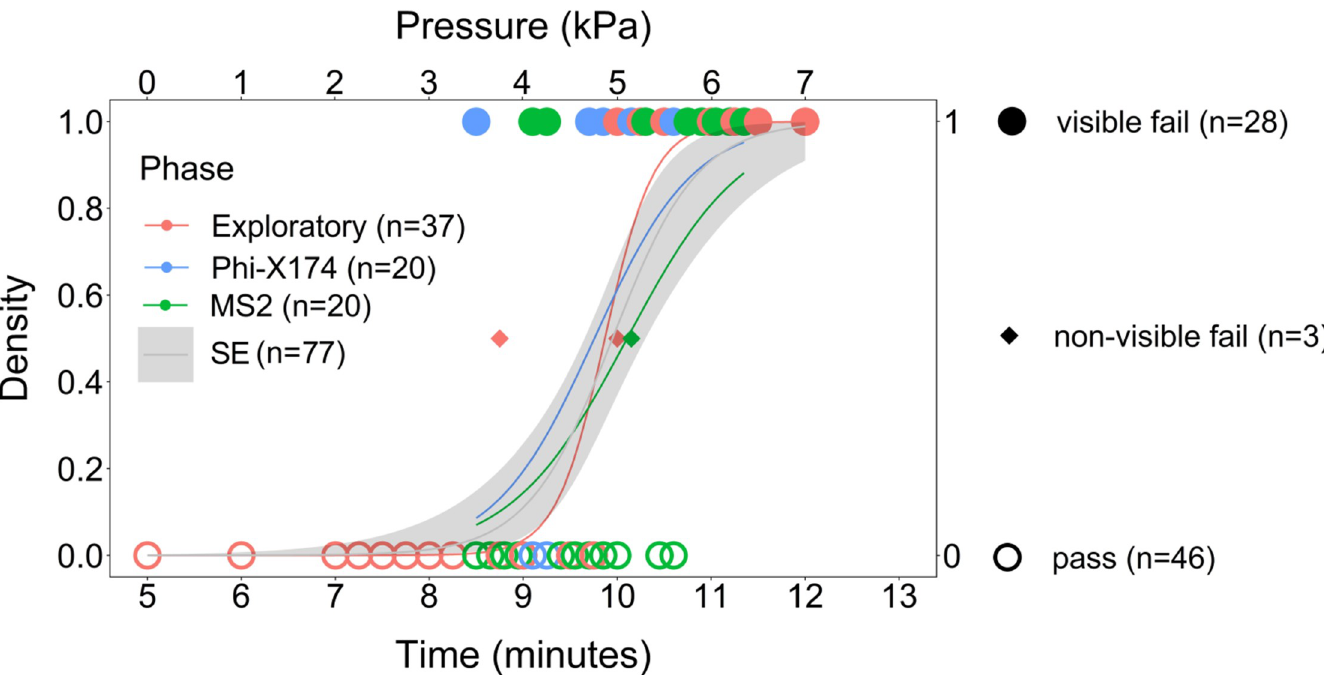
Fig 5. Viral penetration logistic regression of